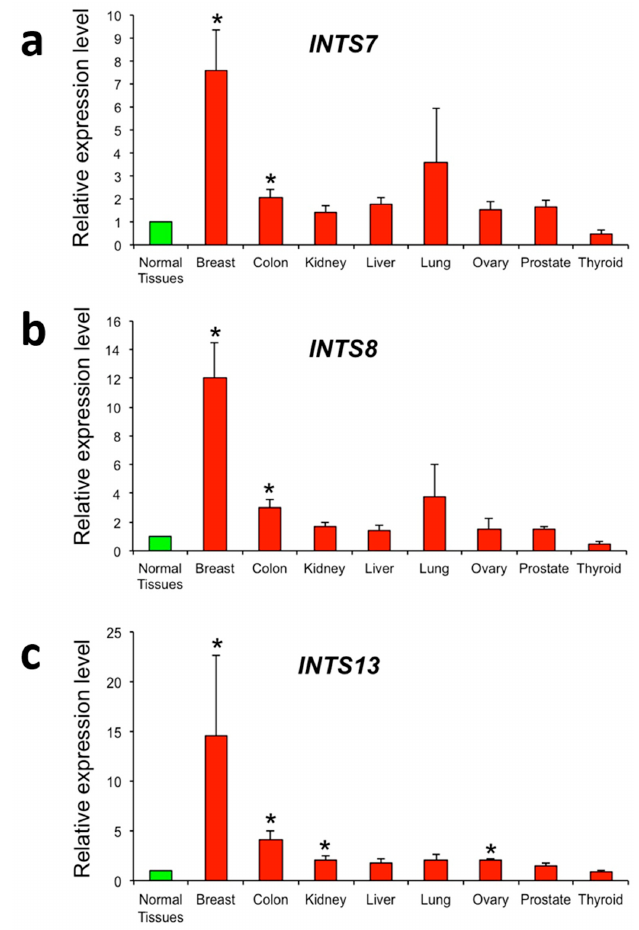
Figure 6. Relative expressions (mean ± ES) obtained by real-time PCR in breast, colon, kidney, liver, lung, ovary, prostate, and thyroid cancer tissues vs. corresponding normal tissues (with arbitrary expression value equal to 1). INTS7 ( a ); INTS8 ( b ) and INTS13 ( c ). Significance: * p < 0.05 vs. normal